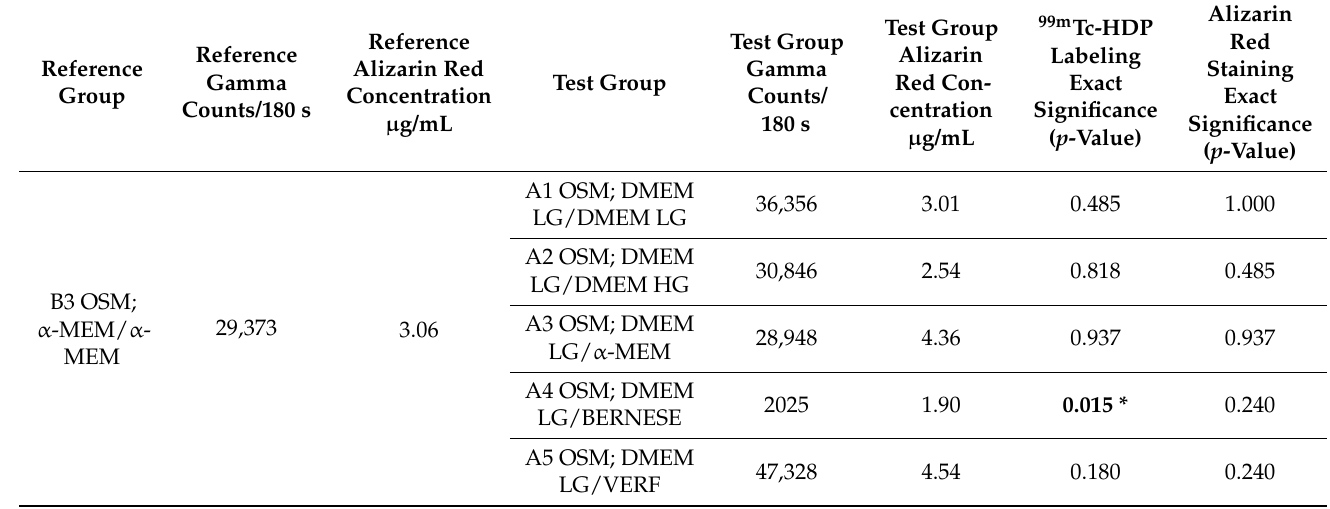
Table 3. Mann–Whitney Test for all osteogenic groups (OSM) when group B3 OSM is defined as